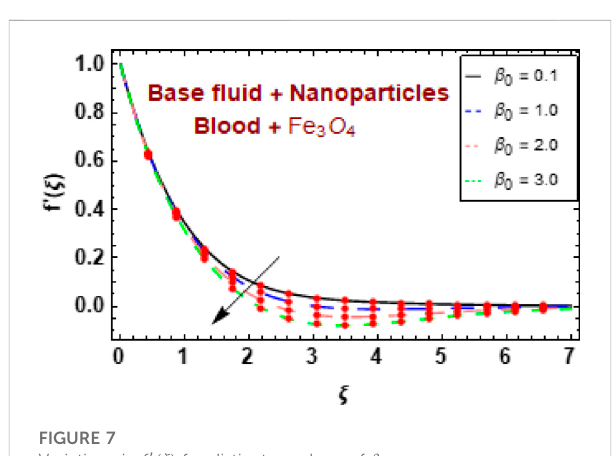
FIGURE 7 Variations in f ′ ( ξ ) for distinct numbers of β 0